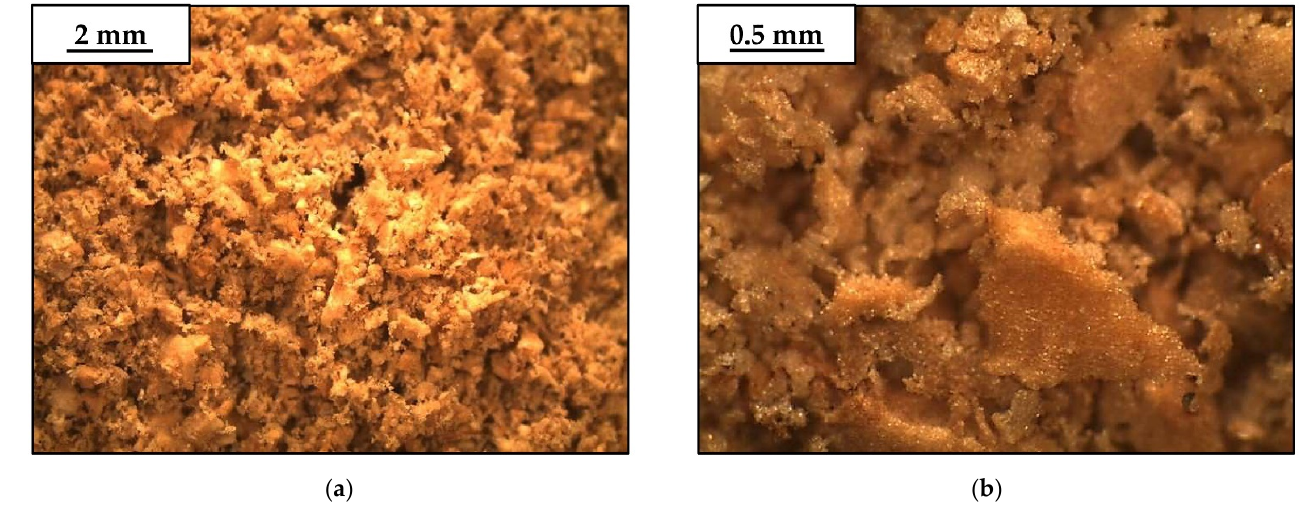
Figure 3. Optical microscopy images of cork waste: ( a ) 8× magnification, ( b ) 35× magnification.